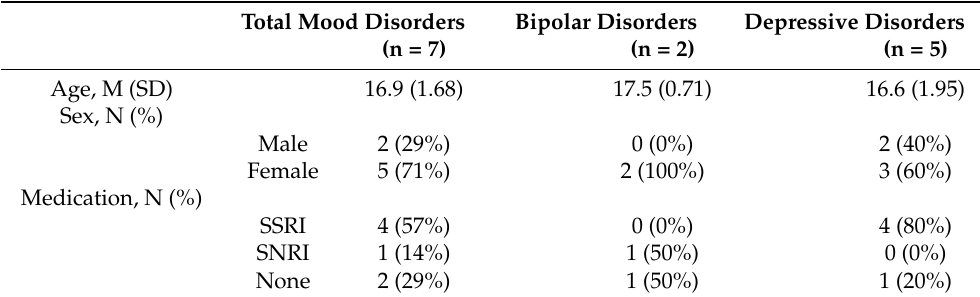
Table 3. Patient cohort demographics and medication use. NLRP3 inflammasome testing was conducted in adolescent patients with mood disorders (n = 7), including two adolescents with bipolar spectrum disorders and five adolescents with depressive disorders. Abbreviations: selective- serotonin reuptake inhibitor (SSRI), serotonin-norepinephrine reuptake inhibitor